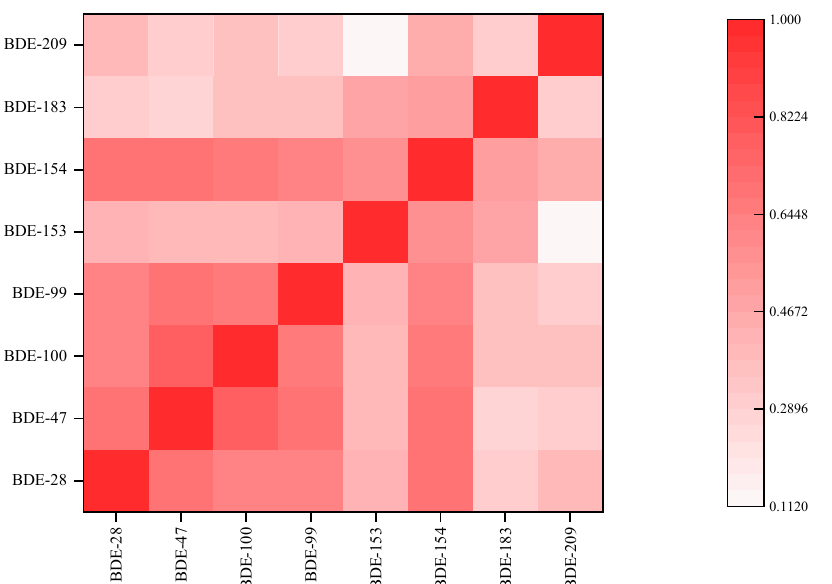
Figure 3. The correlations between the BCF in different PBDE congeners in aquatic organisms col- lected from typical shallow lakes.